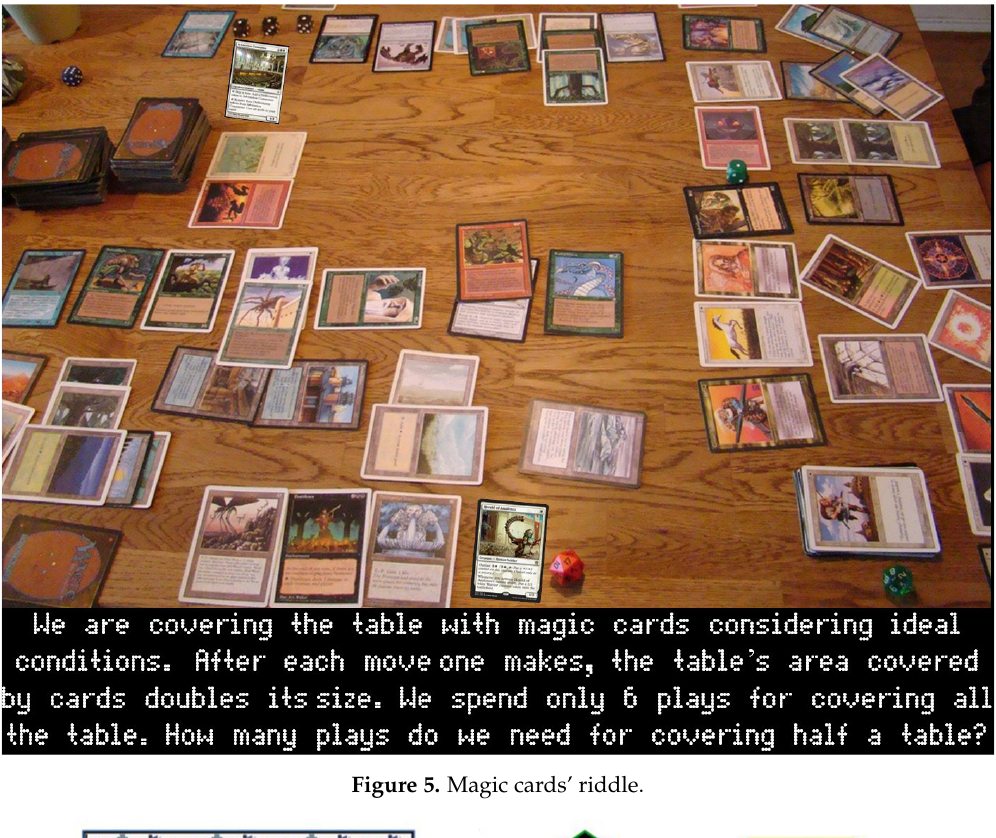
Figure 5. Magic cards’ riddle.